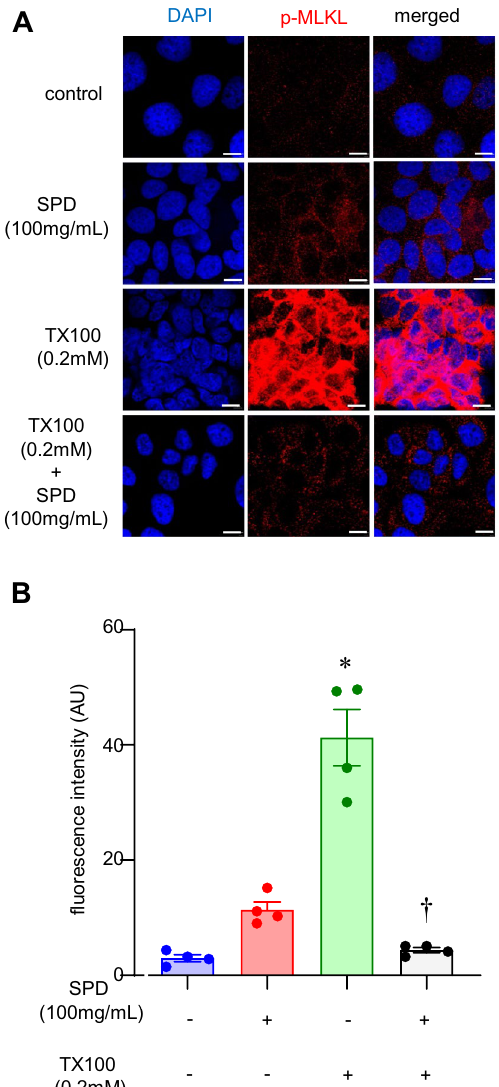
Figure 8. SPD blunted TX100-induced phosphorylation of MLKL. Human keratinocytes (HaCaT) were exposed to TX100 (0.2 mM) for 3 h in presence of SPD (100 mg/ml). Cells were then fixed and immunostained with phospho-MLKL antibody. ( A , B ) Representative microscopic images and quantification of phospho-MLKL was assessed by confocal microscopy. Scale, 10 µm. Data represent mean ± SEM (n = 4). * p < 0.05 compared to control (TX100-untreated). † p < 0.05 compared to TX100-treated